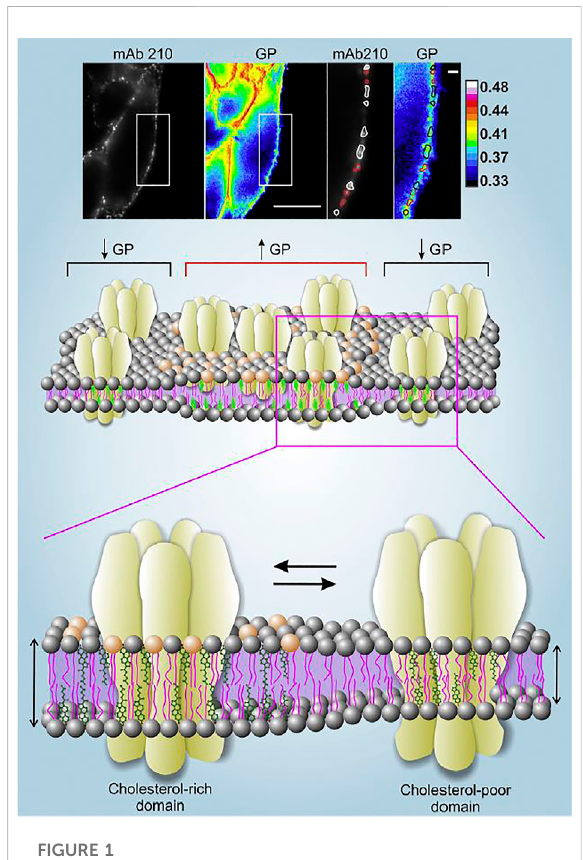
FIGURE 1 Upper panel . Live CHO-K1/A5 cells co-stained with anti- nAChR Alexa647 using the monoclonal antibody mAb210 and the membrane probe di-4-ANEPPDHQ. Regions of the plasma membrane on which the analysis was carried out are highlighted with a white rectangle. nAChR puncta associated with GP values lower than the mean GP of the cell membrane (i.e., Lo domains with lower Chol content) are outlined in white; nAChR clusters with higher-than-the-mean GP are outlined in red. Scale bar: 10 μ m in outlined regions of interest, and 1 μ m in magni fi ed images. Original data from (Kamerbeek et al., 2013). Middle and lower panels . Schematic representation of the distribution of nAChR molecules in liquid-ordered(Lo) and liquid-disordered (Ld) domains rich and poor in cholesterol, respectively. The experimentally determined high GP areas in the upper panel are assumed to correspond to the thicker, cholesterol-rich domains, and vice-versa. Illustration from (Borroni et al., 2016), with